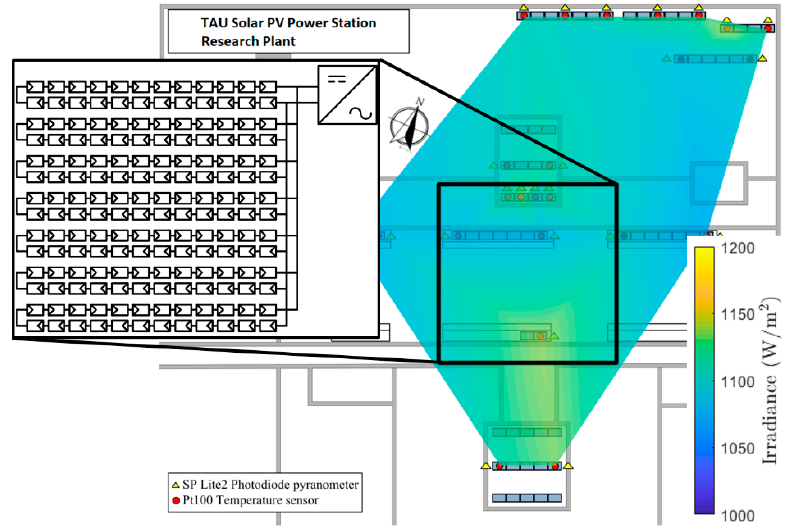
Figure 4. The dimensions and configuration of the PV generator, and its location on the rooftop.